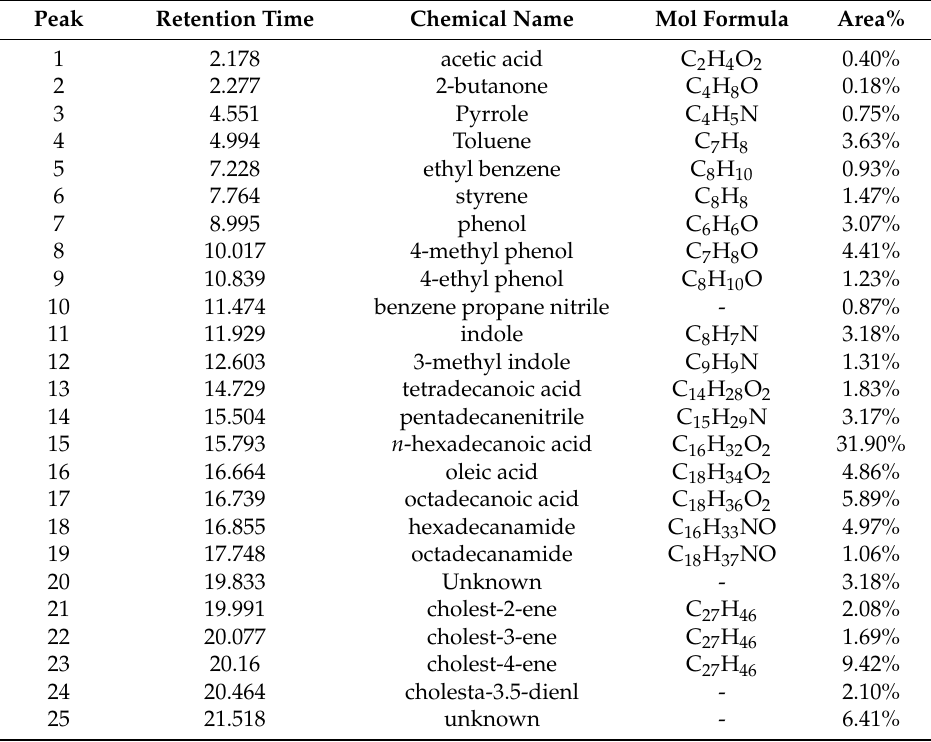
Table 8. GC-MS analysis of sludge pyrolytic